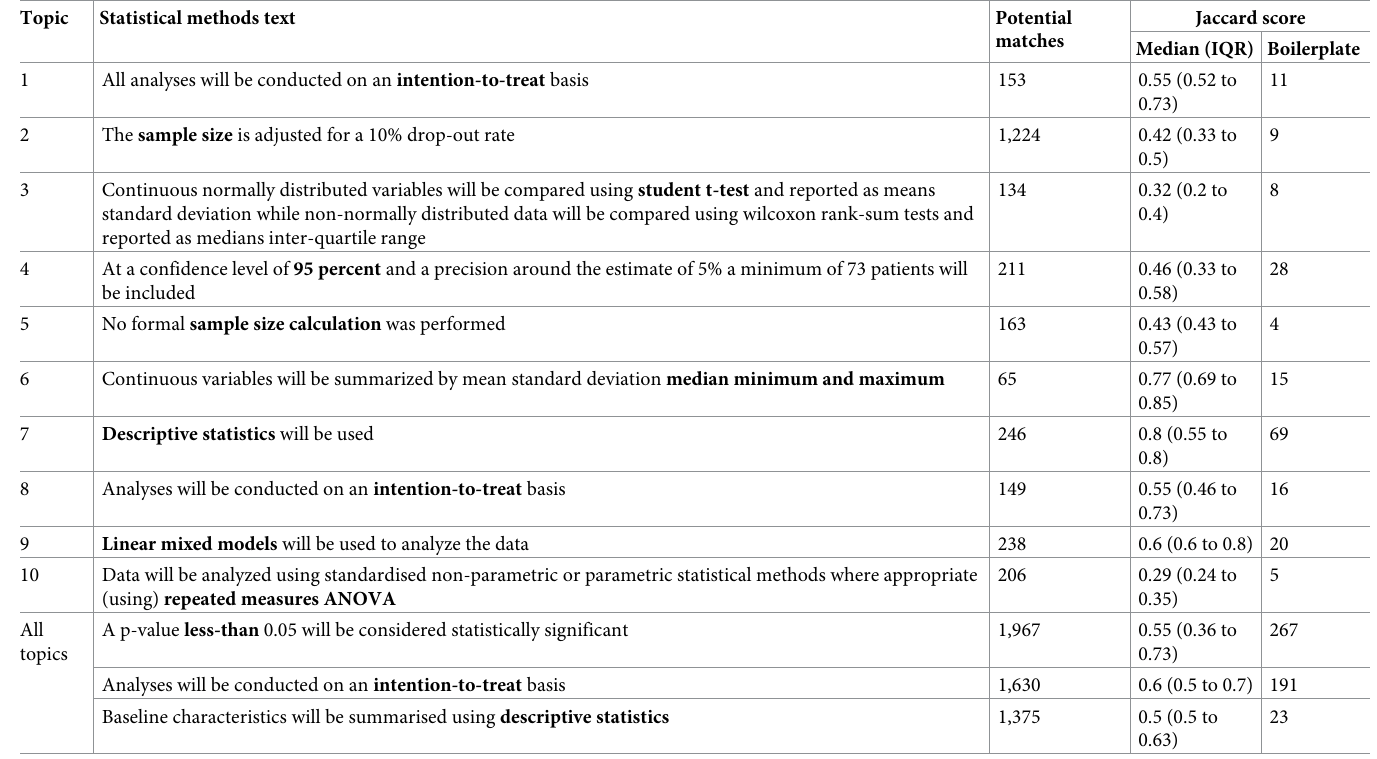
Table 4. Example boilerplate text from ANZCTR studies with the highest number of matches per topic (sentence level).